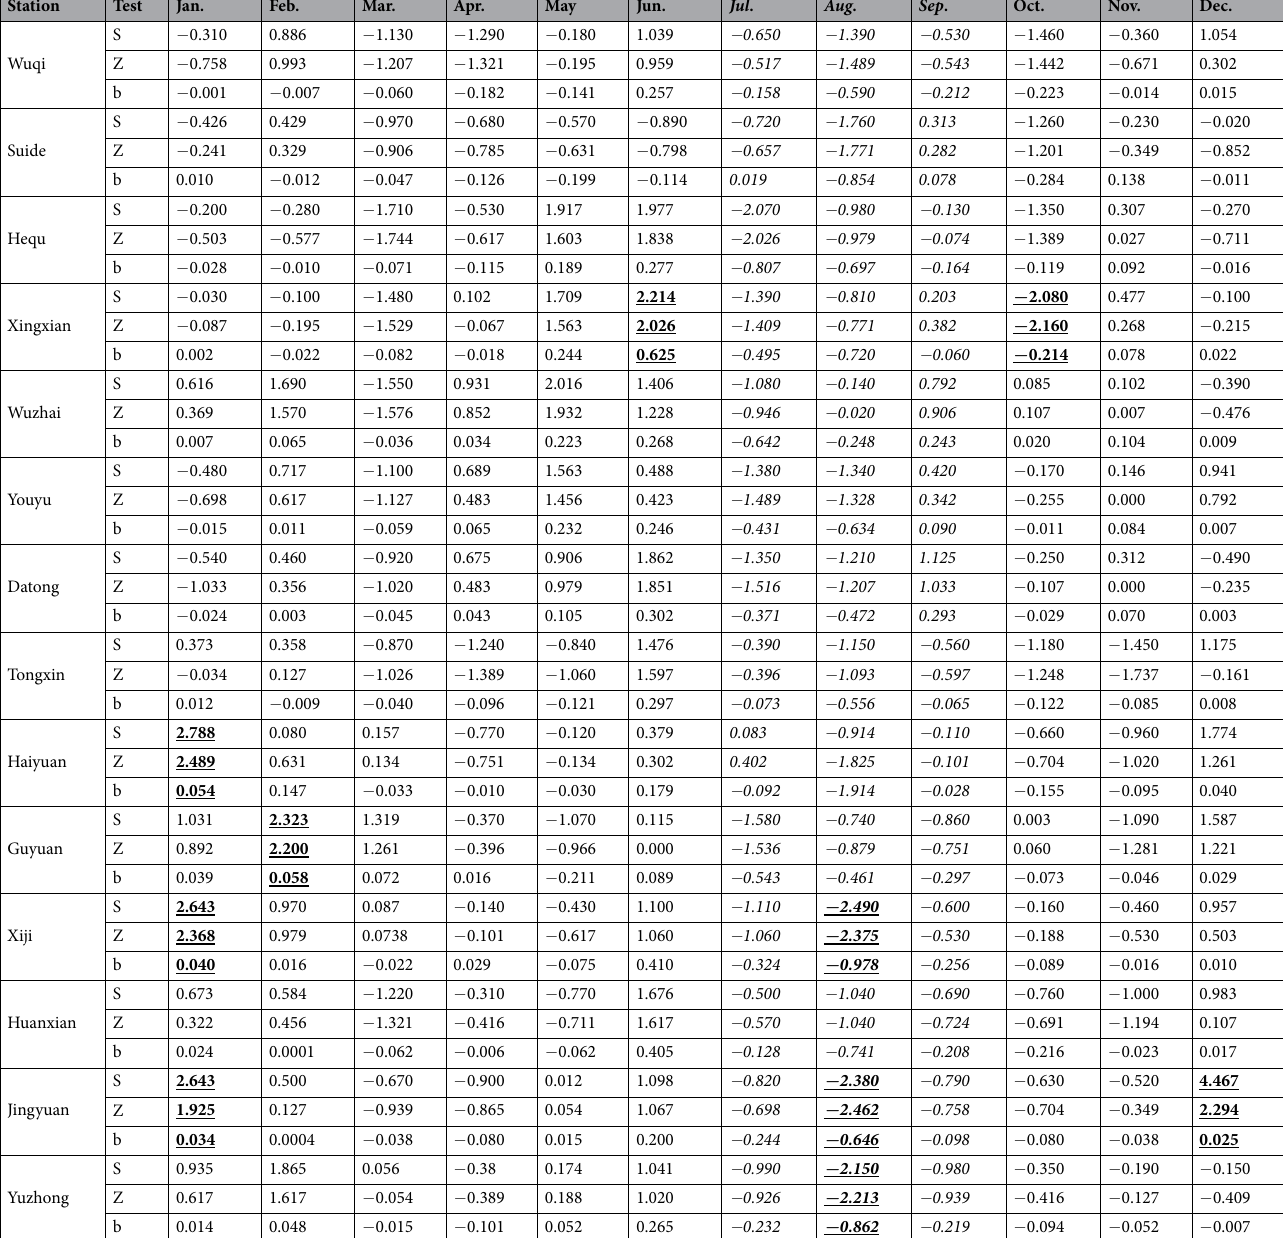
Table 3. Results of the statistical tests of monthly precipitation trends from 1958 to 2015. Cells in italic indicate the rainy season. Z: M-K trend test; S: Spearman’s rho test; and b (mm/a): slope of linear regression. Bold type represents trends identified by 2 statistical methods and trends that are statistically significant at the 5%